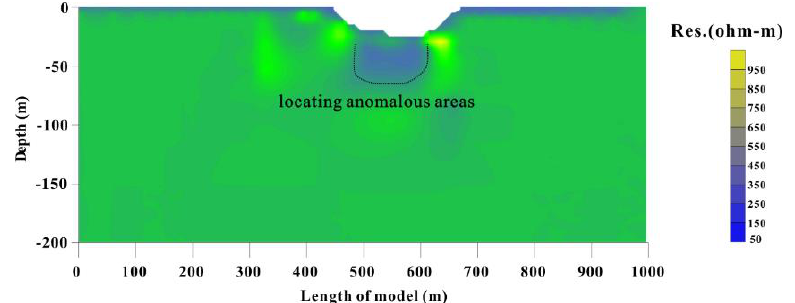
Figure 7. Inversion result of geo-electrical model with terrain.